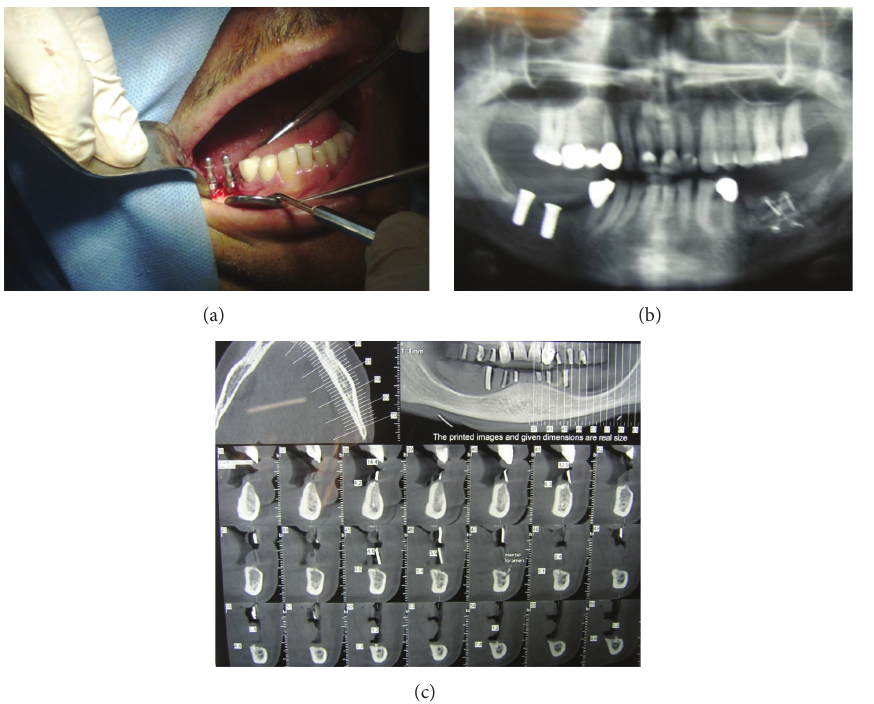
Figure 3: (a) Patient number one, surgery day photo. (b) Patient number one, panoramic X-ray. (c) Patient number one, CT scan.